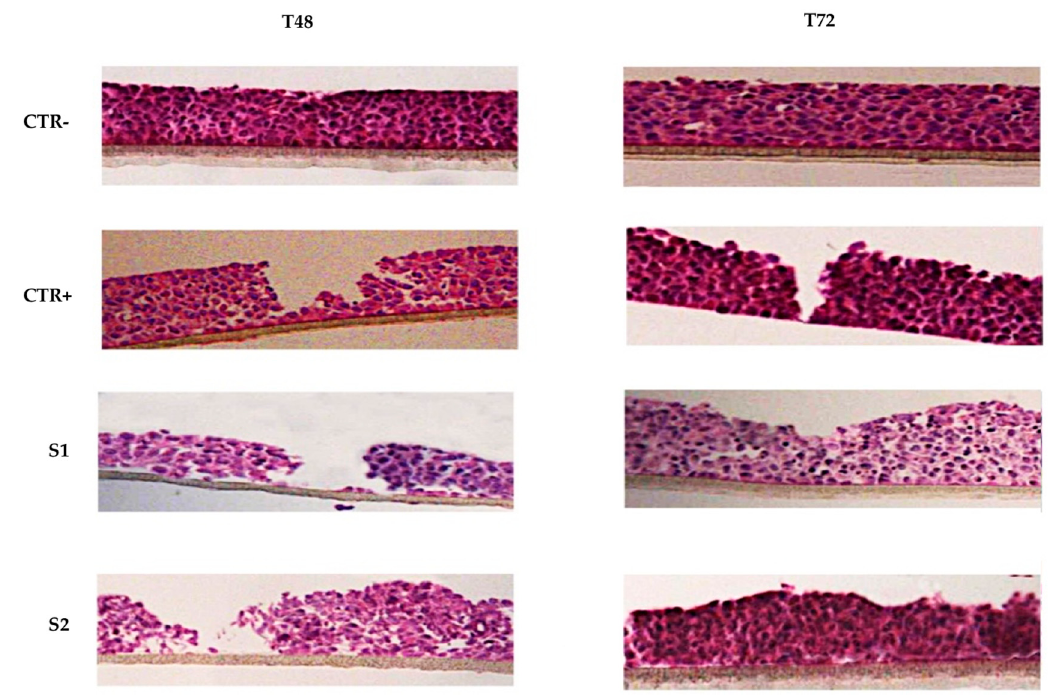
Figure 1. Histological analysis (HE staining) of 3D reconstructed tissues of human corneal epithelium. After wounding, HCE cells were incubated in growth medium with or without S1 and S2 for 72 h. Representative images from each group were recorded at 48 and 72 h post-wounding.